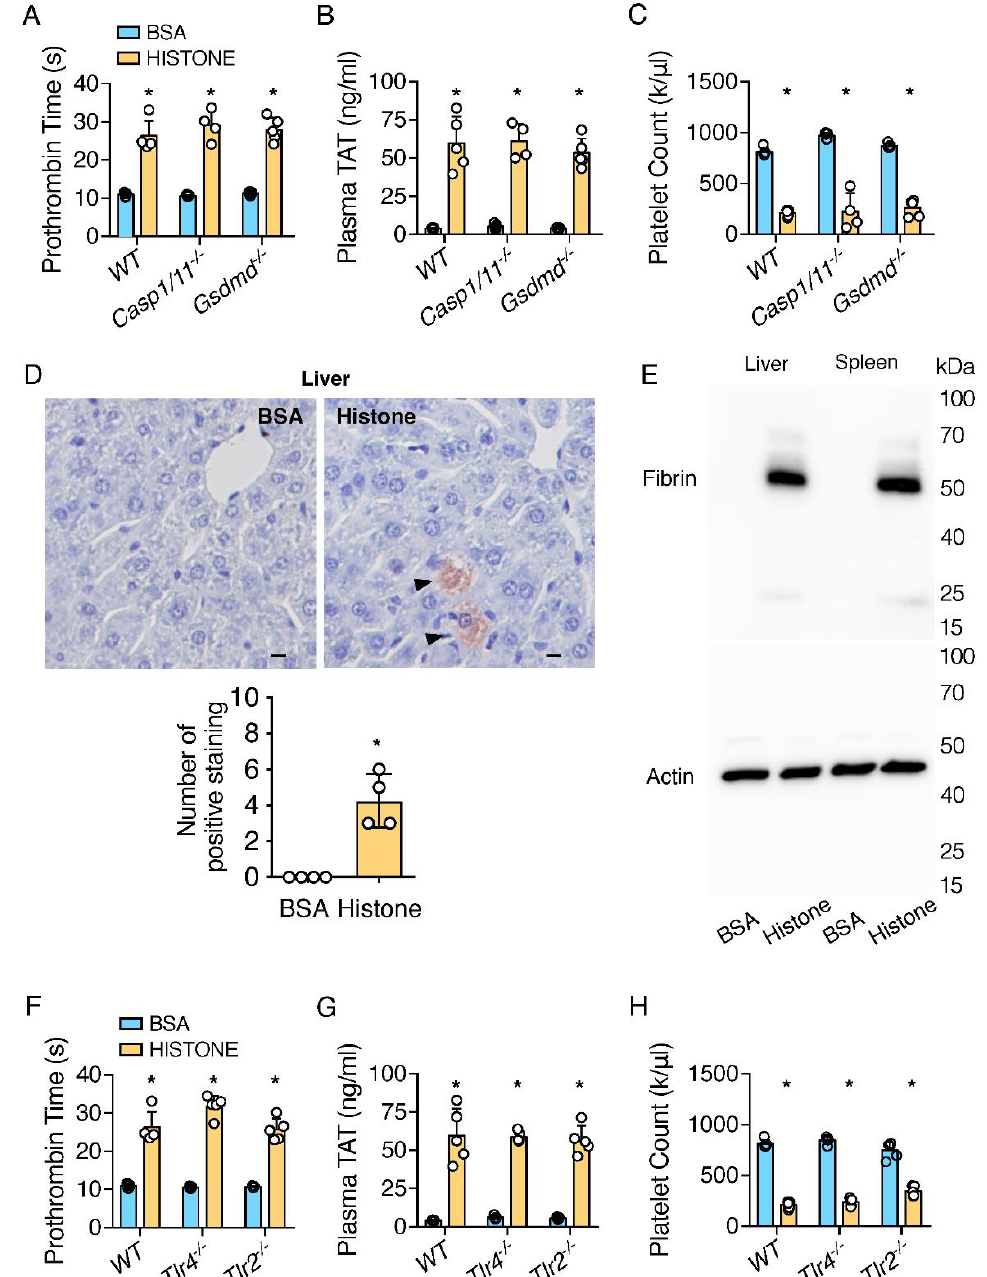
Figure 1. Extracellular histones triggered coagulopathy independent of inflammasome pathways and TLR receptors. ( A – C ) C57BL/6J mice (WT), Casp1/11-deficient mice, and GSDMD-deficient mice were injected intravenously with BSA or histones. Blood was collected 60 min after injection. Prothrombin time ( A ), plasma TAT concentrations ( B ), and total platelet count ( C ) were measured. Error bars denote SD; * p < 0.05 versus BSA, Mann–Whitney test. ( D ) C57BL/6J mice (WT) were injected intravenously with BSA or histones. After 60 min, the mice were perfused with PBS and then perfusion-fixed with 10% ( v / v ) formalin under physiological pressure for 45 min. Liver sections were immunostained with anti-fibrin monoclonal antibody (59D8). Wild-type mice showed fibrin deposition in the liver (arrows). Scale bars denote 10 µm. Numbers of positive staining were quantified on images acquired at 20X or equivalent. Error bars denote SD; * p < 0.05 versus BSA, Mann – Whitney test. ( E ) C57BL/6J mice (WT) were injected intravenously with BSA or histones. After 60 min, the mice were euthanized, and their tissues were harvested. Fibrin in the tissue lysates was detected by immunoblot with the anti-fibrin monoclonal antibody 59D8. Data are representative of 3 independent experiments. ( F – H ) C57BL/6J mice, TLR4-deficient mice, and TLR2-deficient mice